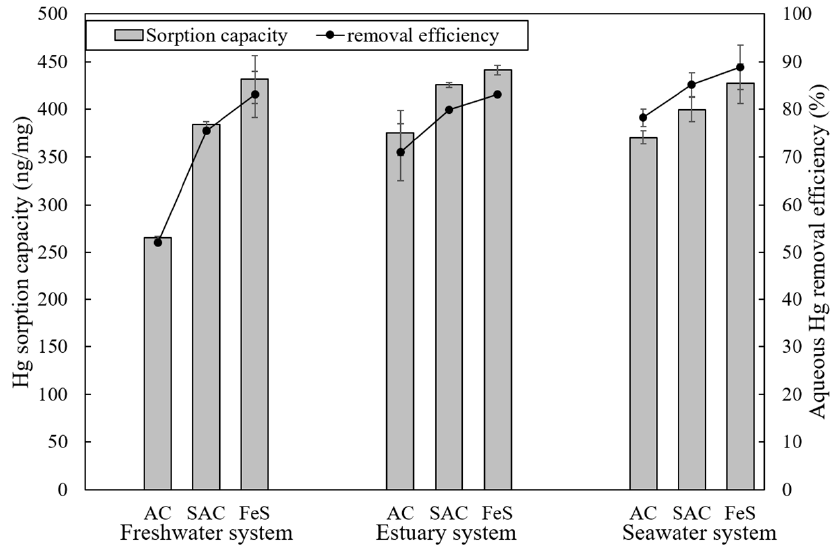
Figure 4. Comparison of various salinity levels affecting the sorbents’ Hg removal.